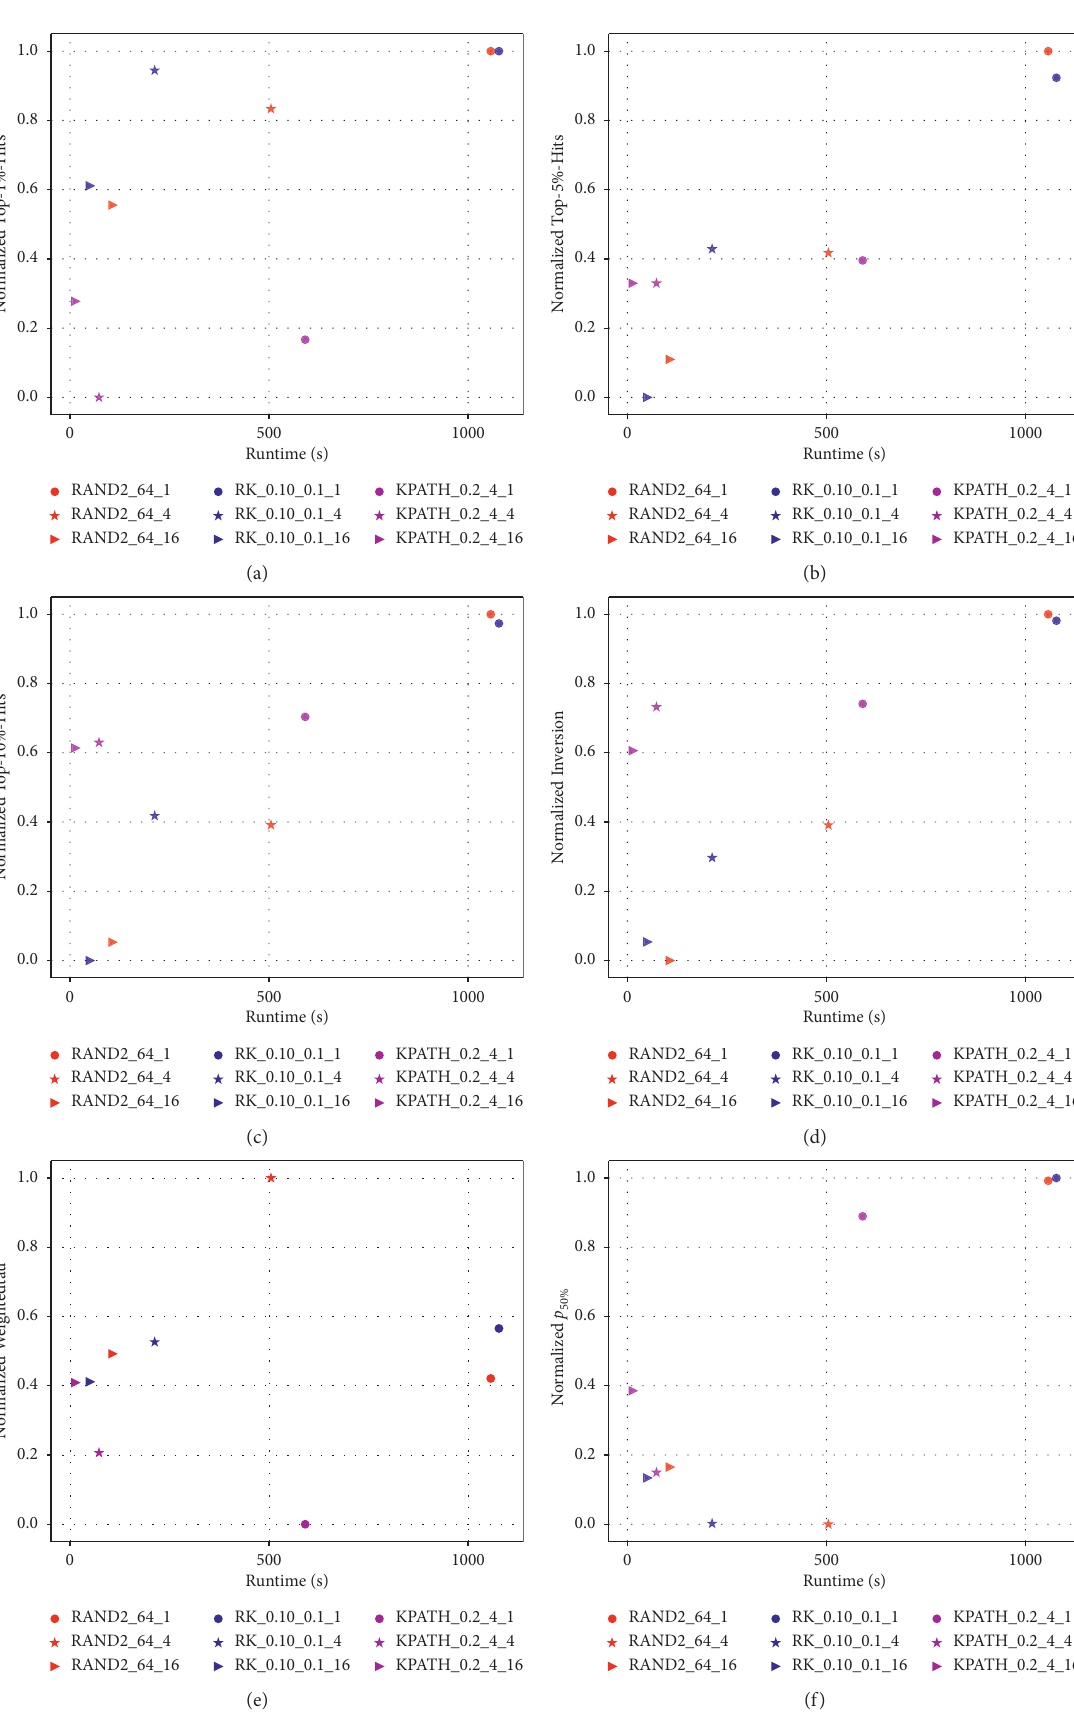
Figure 13: Trade-offs on inf-power network with 4941